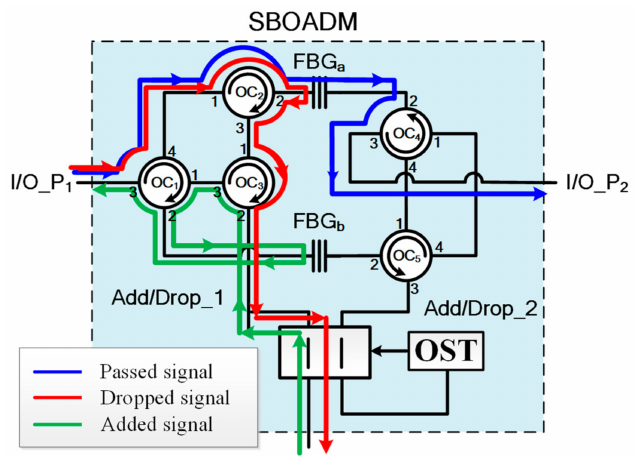
Figure 3. Structure of SBOADM (the optical signals are fed from the left-hand